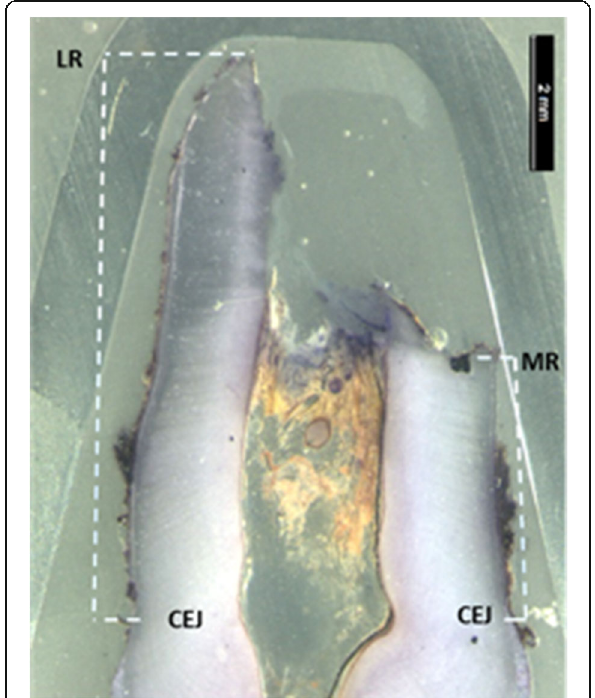
Fig. 2 Microscopic image of an extracted deciduous canine showing slanted root resorption and how the root length measurements from cemento-enamel junction (CEJ) to the most resorbed (MR) side and from CEJ to the less resorbed (LR) root side were